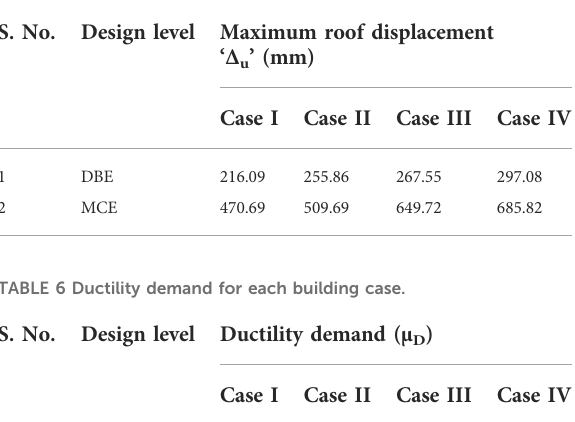
TABLE 5 Maximum roof displacement for each building case.